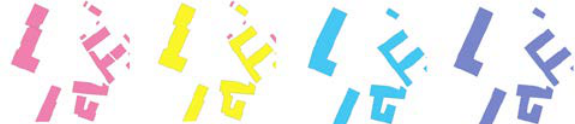
Figure 2. Generalization of buildings: top to bottom, left to right, original situation, aggregation and selection, simplification,